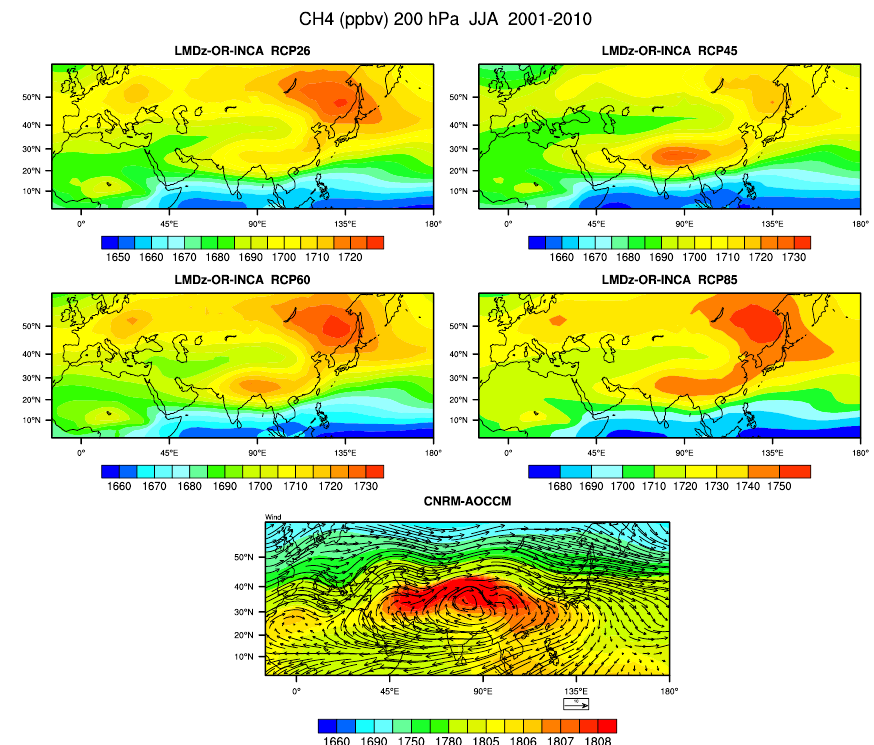
Figure 11. Fields of CH 4 as calculated by the CNRM-AOCCM model (bottom) and the LMDz-OR-INCA model (top and centre) considering the four IPCC scenarios (RCPs 2.6 (top left), 4.5 (top right), 6.0 (centre left) and 8.5 (centre right)) at 200hPa averaged over the summer season (JJA) and the climatological period 2001–2010. Superimposed on the CNRM-AOCCM CH 4 fields (bottom) is the wind field at 200hPa averaged over the same period. Note that the range of the colour scale changes for each figure and that the colour scale for the CNRM-AOCCM model (bottom) is